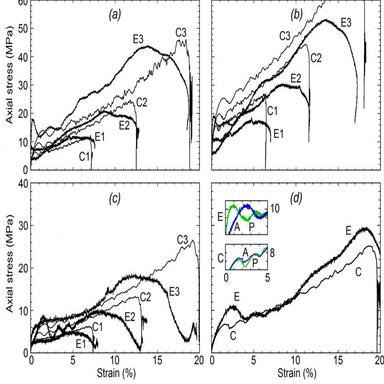
The calculated stress-strain response with fitted compaction kinetic compared with the experiments for the calcite sand: as-received, ρ0 = 1.33(1), 1.33(2), 1.34(3) g/cm3 (a), pre-compacted, ρ0 = 1.47(1), 1.465(2), 1.47(3) g/cm3 (b), moisturised, ρ0 = 1.335(1), 1.335(2), 1.34(3) g/cm3 (c), and moisturised, confined with aluminium collar, ρ0 = 1.34 g/cm3 , and polycarbonate collar, ρ0 = 1.35 g/cm3 (d), where 1, 2 and 3 correspond to different strain rates.